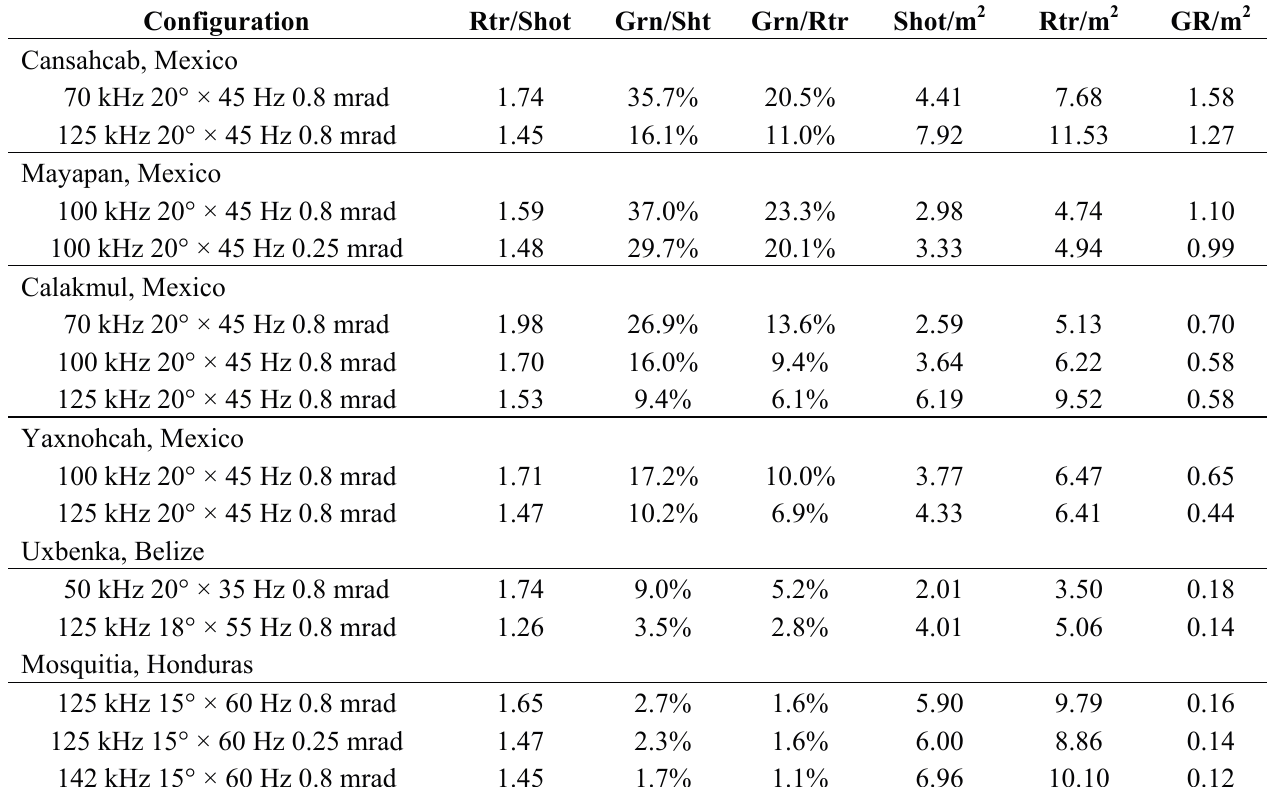
Table 2. Summary of ALS canopy penetration experiments. Abbreviations used in the Table heading are Rtr for return, Sht for LASER shot and GR for ground